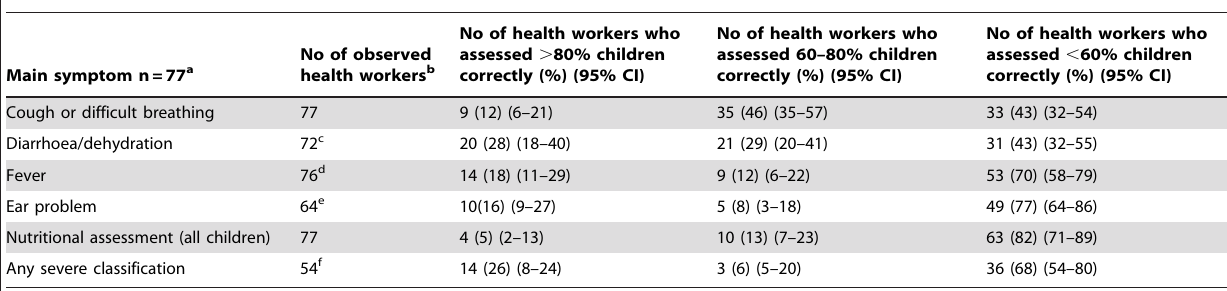
Table 2. Proportion of children with each main symptom assessed correctly by health workers’ during the observation period.